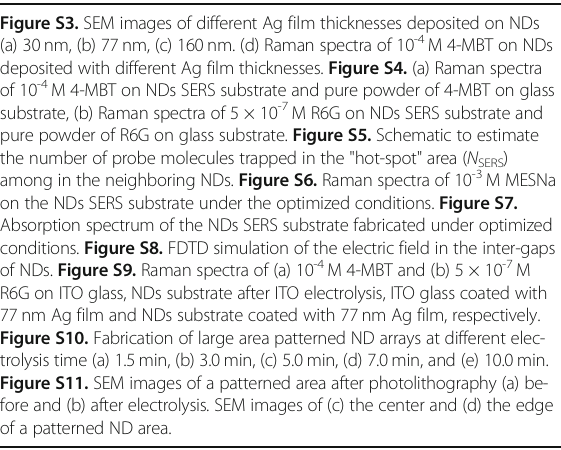
Additional file 1: Figure S1. EDS spectrum of ITO film. Figure S2. (a) SEM image of original FTO film. (b-e) SEM images of FTO film after electrolysis at different applied voltage 50, 100, 150 and 200V, respectively.